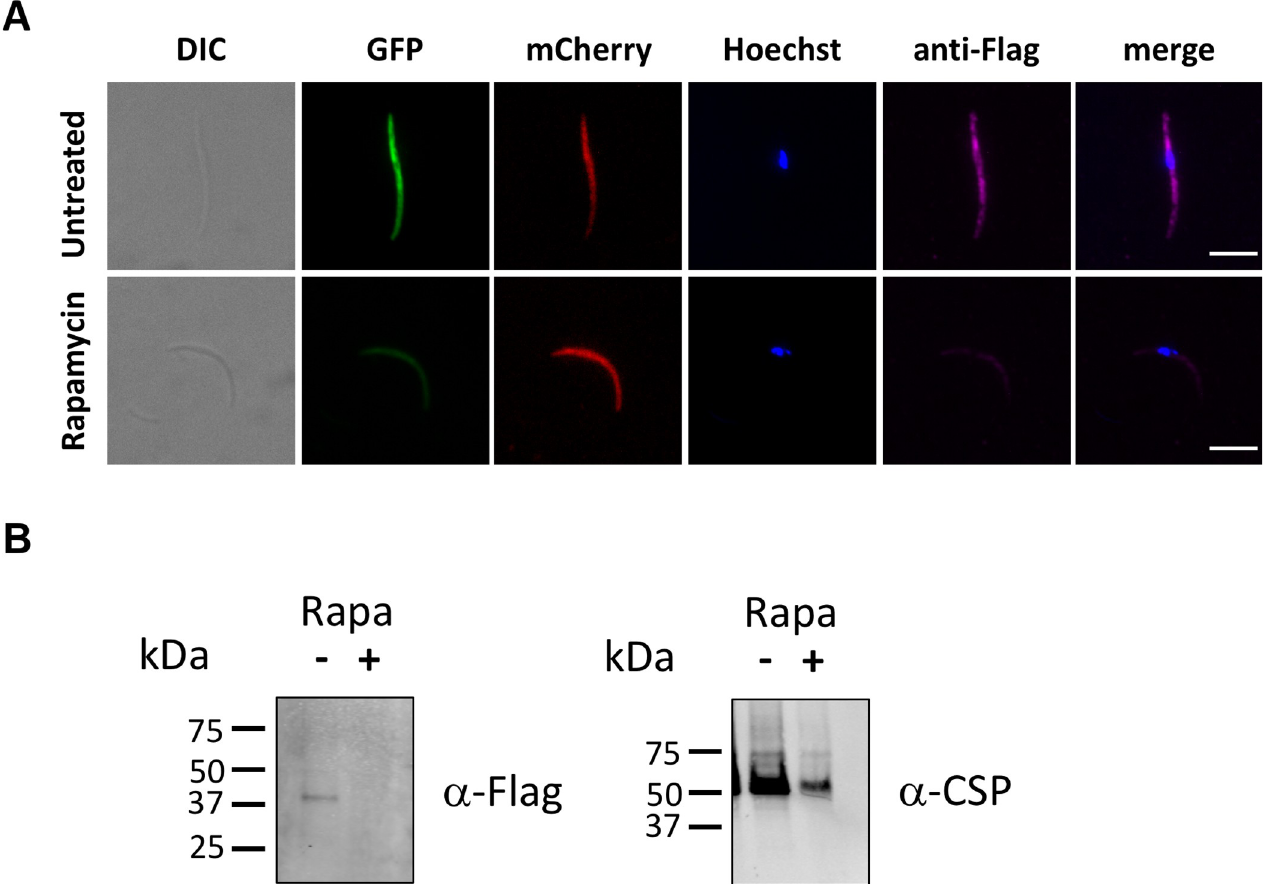
Fig 3. Conditional gene deletion abrogates CLAMP protein expression in sporozoites. A. Immunofluorescence analysis of rapamycin-exposed and untreated clamp cKO sporozoites labelled with anti-Flag antibodies (magenta). Both rapamycin-exposed and untreated clamp cKO parasites express mCherry (red), while only untreated clamp cKO parasites express GFP (green). Nuclei were stained with Hoechst 77742 (blue). Scale bar, 5 μ m. B. Western bot analysis of haemolymph sporozoite lysates from untreated or rapamycin-treated parasites, using anti-Flag antibodies to detect CLAMP. CSP was used as a loading